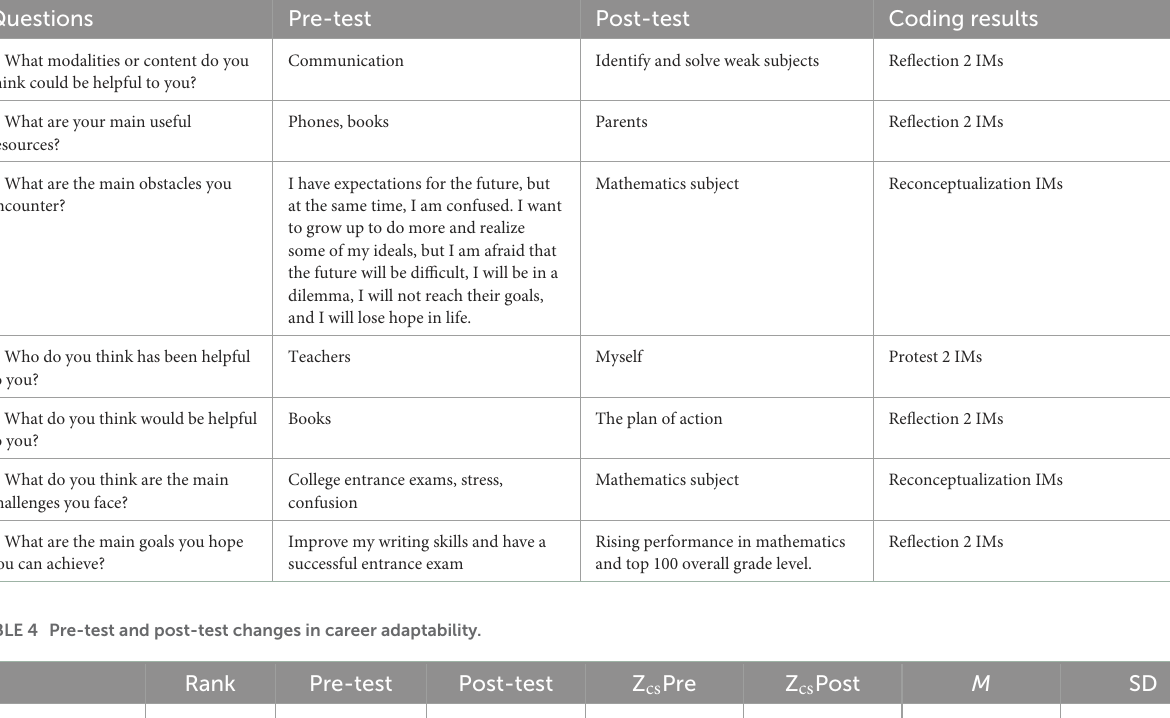
TABLE 3 The pre-test and post-test of the Innovation Moment Coding System.